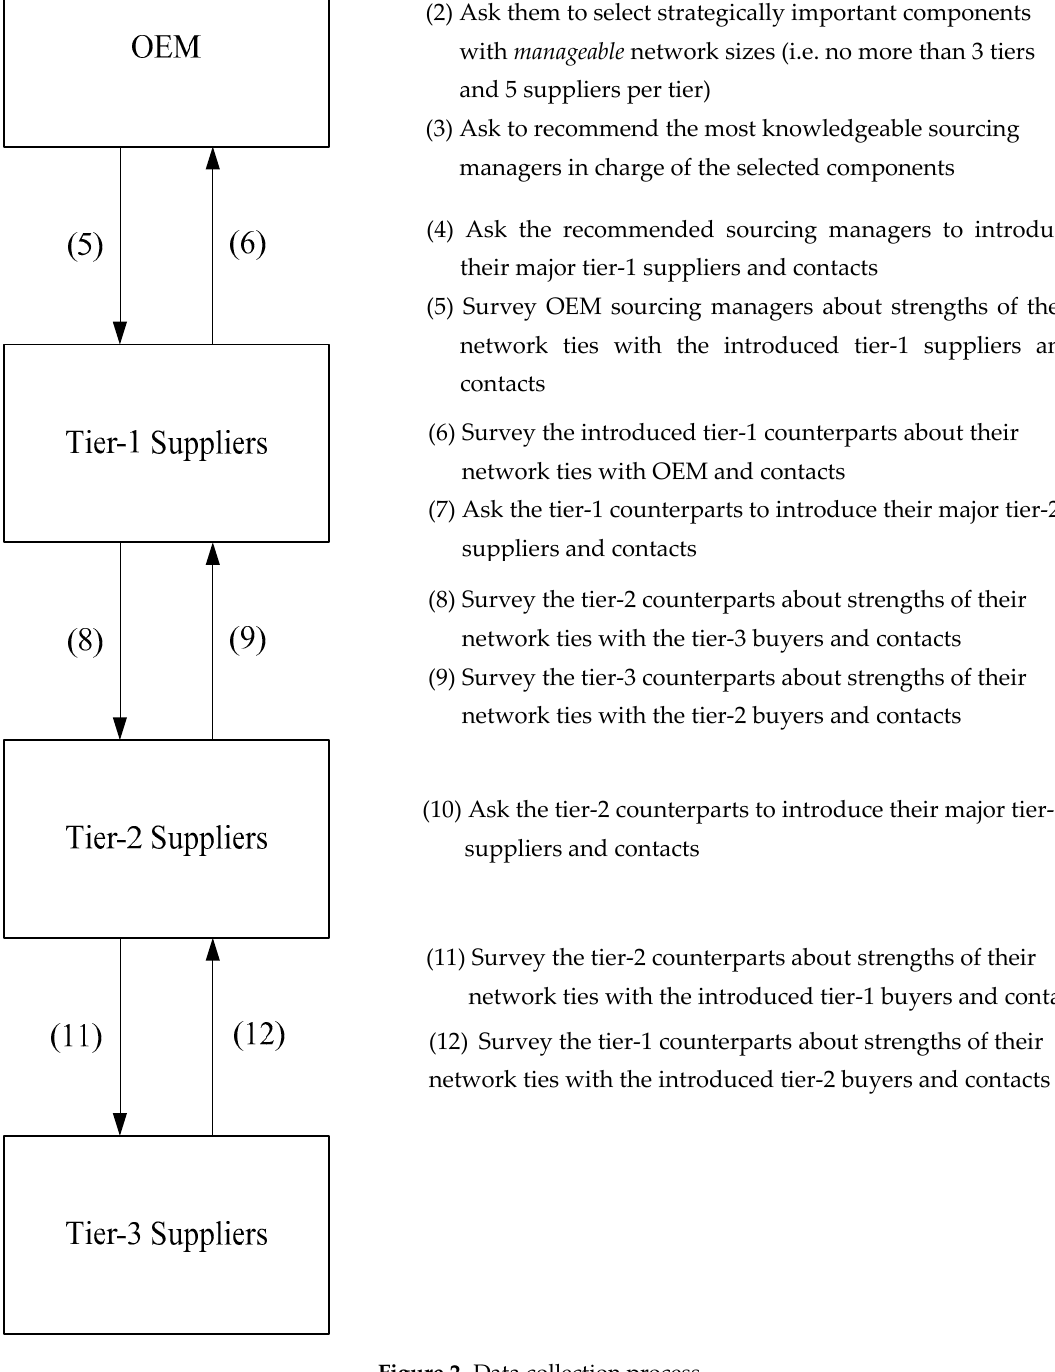
Figure 2. Data collection process.